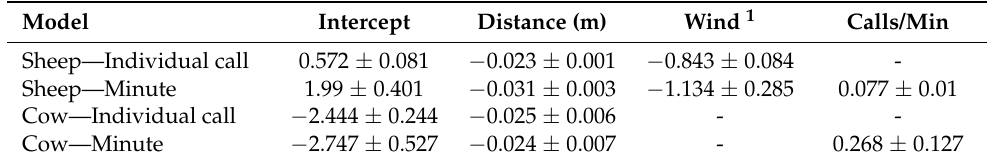
Table 5. Coefficients and standard errors of logistic regression models for detecting or not detecting sheep and cow calls at the individual call level and at minute level—i.e., detecting at least one call in minutes with one or more calls. All coefficients are significant ( p <